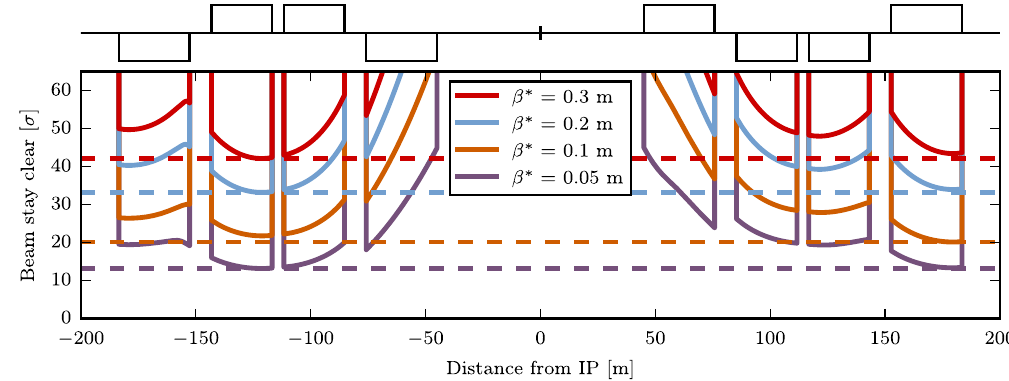
FIG. 12. Beam stay clear of the L (cid:2) ¼ 45 m lattice for different values of β (cid:2) . Allowing a beam stay clear of only 12 σ , the aperture allows a β (cid:2) down to 0.05m. Alternatively, the ultimate baseline goal of β (cid:2) ¼ 0 . 3 m leaves a beam stay clear of 42 σ , allowing thicker shielding. The beam stay clear was calculated with 15 mm of shielding in every magnet.